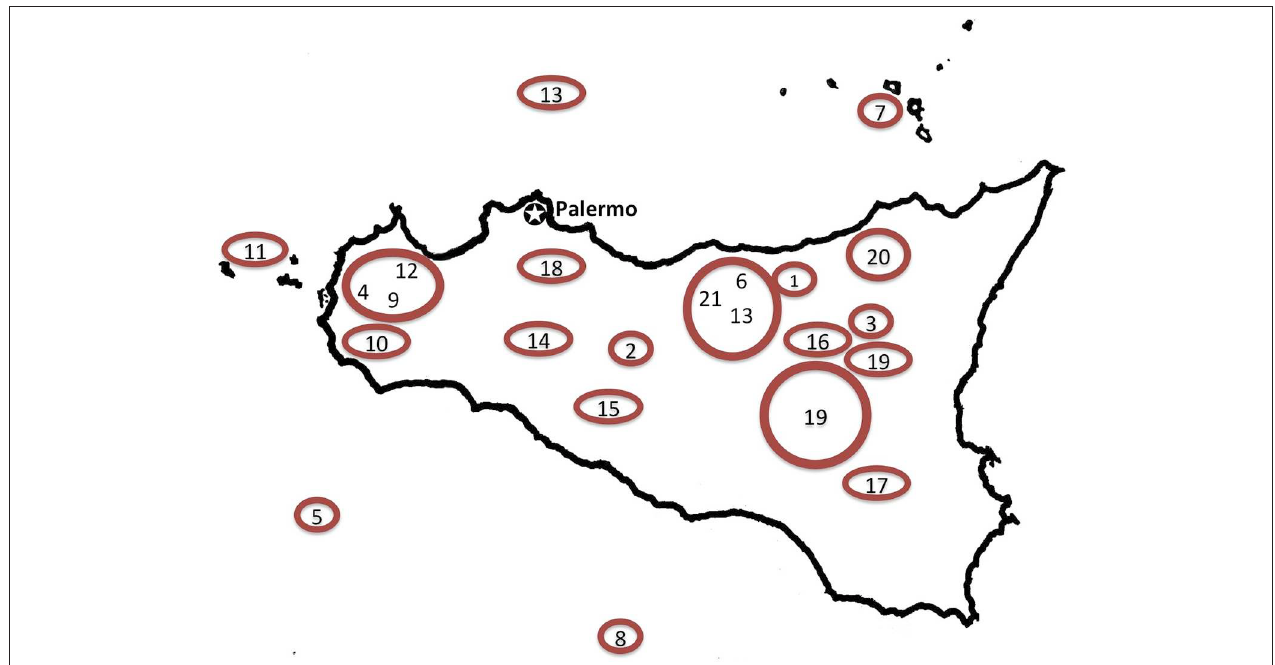
FIGURE 3 | Map of Sicily indicating considered field studies addressing popular medicinal plant use. 1, Mistretta; Messina (Lentini and Raimondo, 1990); 2, Mussomeli; Caltanissetta ( Amico and Sorge, 1997); 3, Cesarò; Messina (Barbagallo et al., 1979); 4, Erice; Trapani (Lentini and Aleo, 1991); 5, Pantelleria; Trapani (Galt and Galt, 1978 ); 6, Madonie, Palermo (Raimondo and Lentini, 1990); 7, Eolie, Messina (Lentini et al., 1995); 8, Pelagie, Agrigento (Lentini et al., 1996); 9, Trapani ( Lentini, 1987); 10, Mazara del Vallo; Trapani (Lentini et al., 1987–1988); 11, Egadi; Trapani (Lentini et al., 1997); 12, Riserva Naturale Dello Zingaro; Trapani